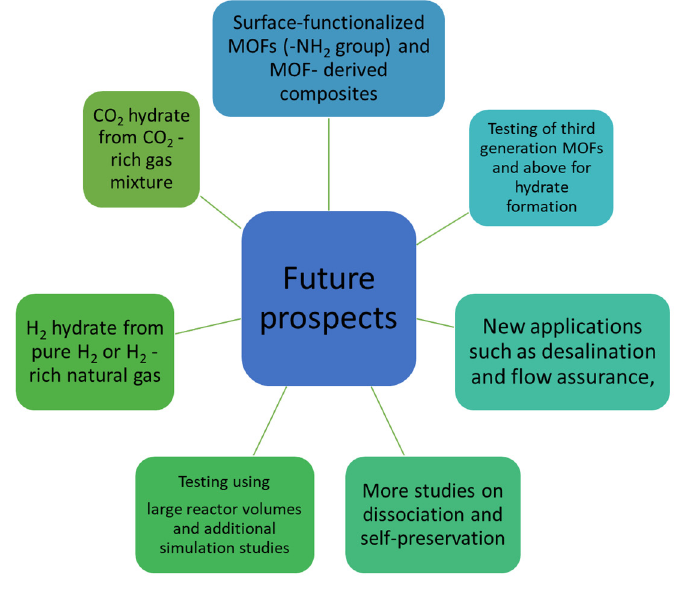
Figure 18. Authors’ opinion concerning future research prospects studying MOF–hydrate synergy. Some of the main conclusions and the way forward are highlighted below.